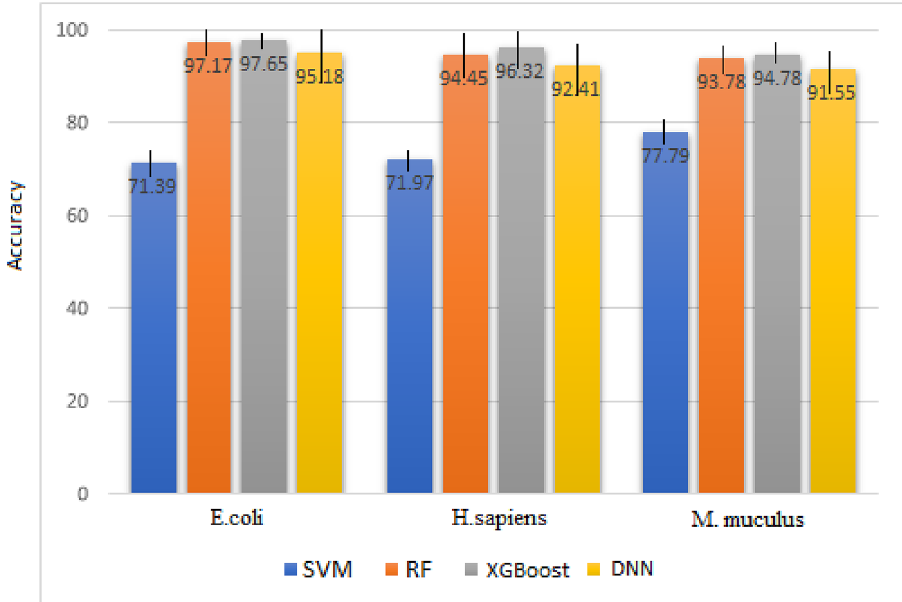
Figure 6. Studying classification models based on error bars for E. coli , M. musculus , and H. sapiens .